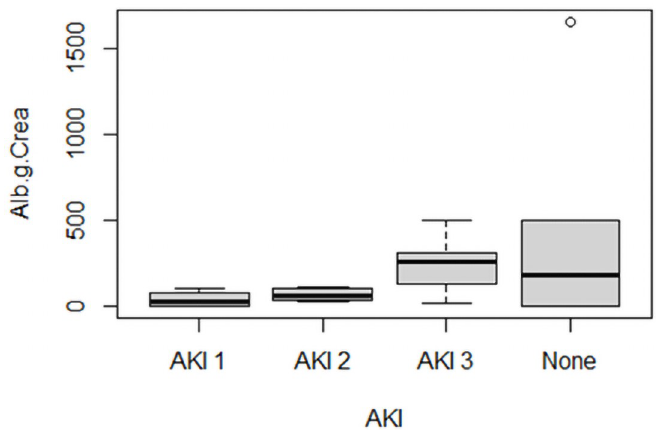
Fig 3. Selective proteinuria in COVID-19 patients with AKI. AKI acute kidney injury, 1: 0 to 106 mg/gCrea, AKI 2: 29 to 112 mg/gCrea, AKI 3: 17 to 500 mg/gCrea, None: 0 to 1660 mg/gCrea.